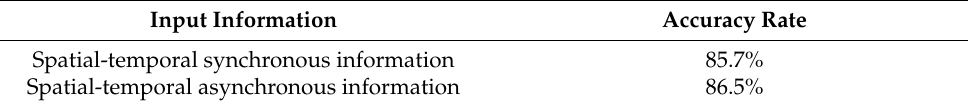
Table 5. Effects of spatial-temporal information on accuracy.